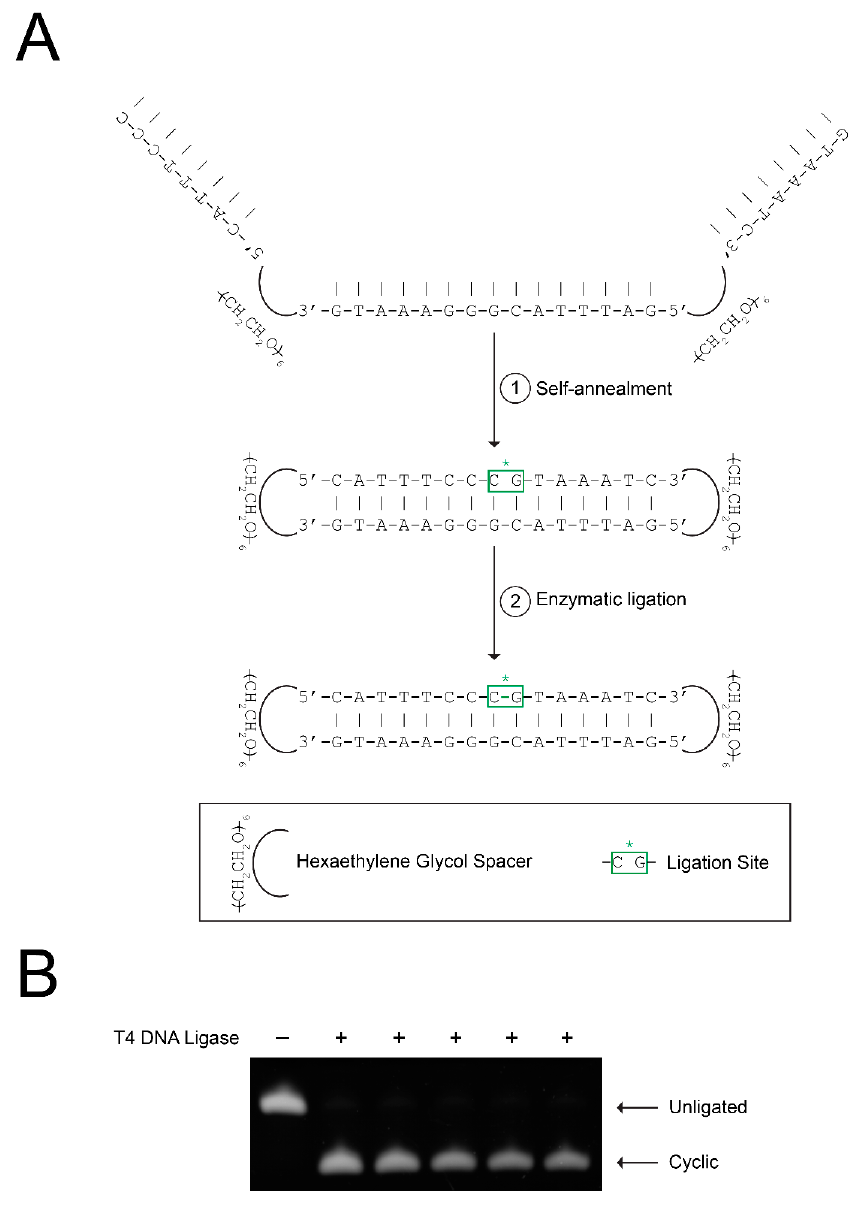
Figure 1. Efficient ligation of cyclic signal transducer and activator of transcription 3 (STAT3) decoy (CS3D). ( A ) Schematic representation of CS3D ligation with T4 DNA ligase. The complementary segments of the single-stranded decoy molecule spontaneously self-anneal. Enzymatic ligation